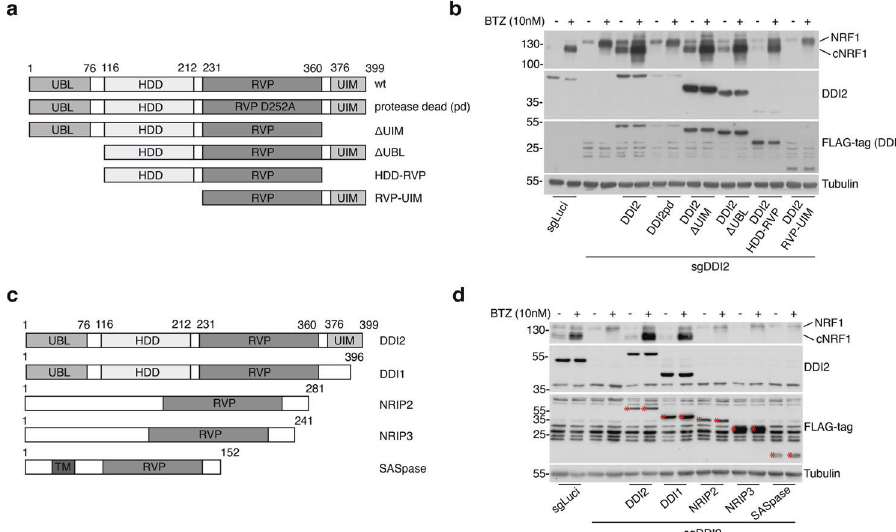
Fig. 4 The RVP and HDD domains of DDI2 are essential and suf fi cient for NRF1 maturation. a Schematic diagram of the different doxycycline-inducible and N-ter FLAG-tagged DDI2 constructs used in this study. These constructs were engineered with a silent mutation impairing Crispr/Cas9 cleavage and stably introduced in ARH77 cells de fi cient for DDI2. b Protein expression of NRF1, DDI2, and FLAG was analyzed by immunoblot blot upon treatment with doxycycline, in the presence or absence of BTZ. c Schematic diagram of the different doxycycline-inducible and FLAG-tagged constructs expressing known RVP-containing proteases. d DDI2-de fi cient ARH77 cells were stably reconstituted with the constructs depicted in c . Cells were treated with doxycycline and BTZ as indicated, and protein expression for NRF1, DDI2, and FLAG-tagged proteins was analyzed by immunoblotting. Tubulin is used as a loading control. The white stars are there to differentiate the FLAG-tagged proteins from the background